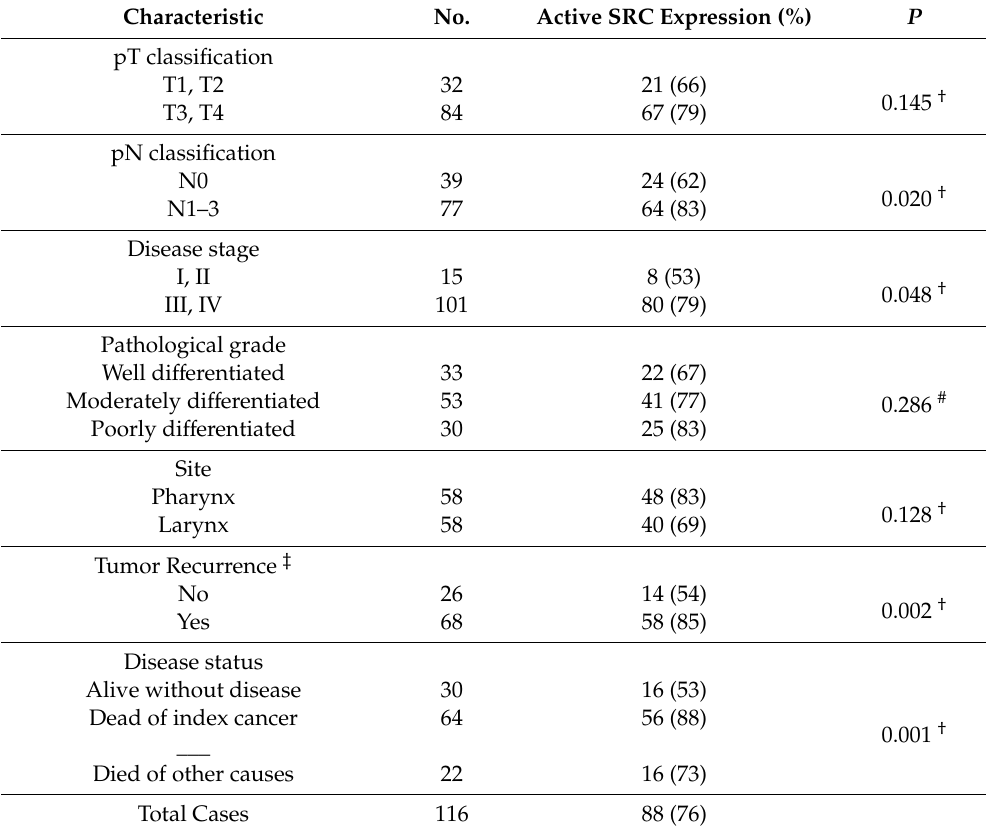
Table 1. Associations between the expression of active SRC and clinicopathological parameters, recurrence, and disease